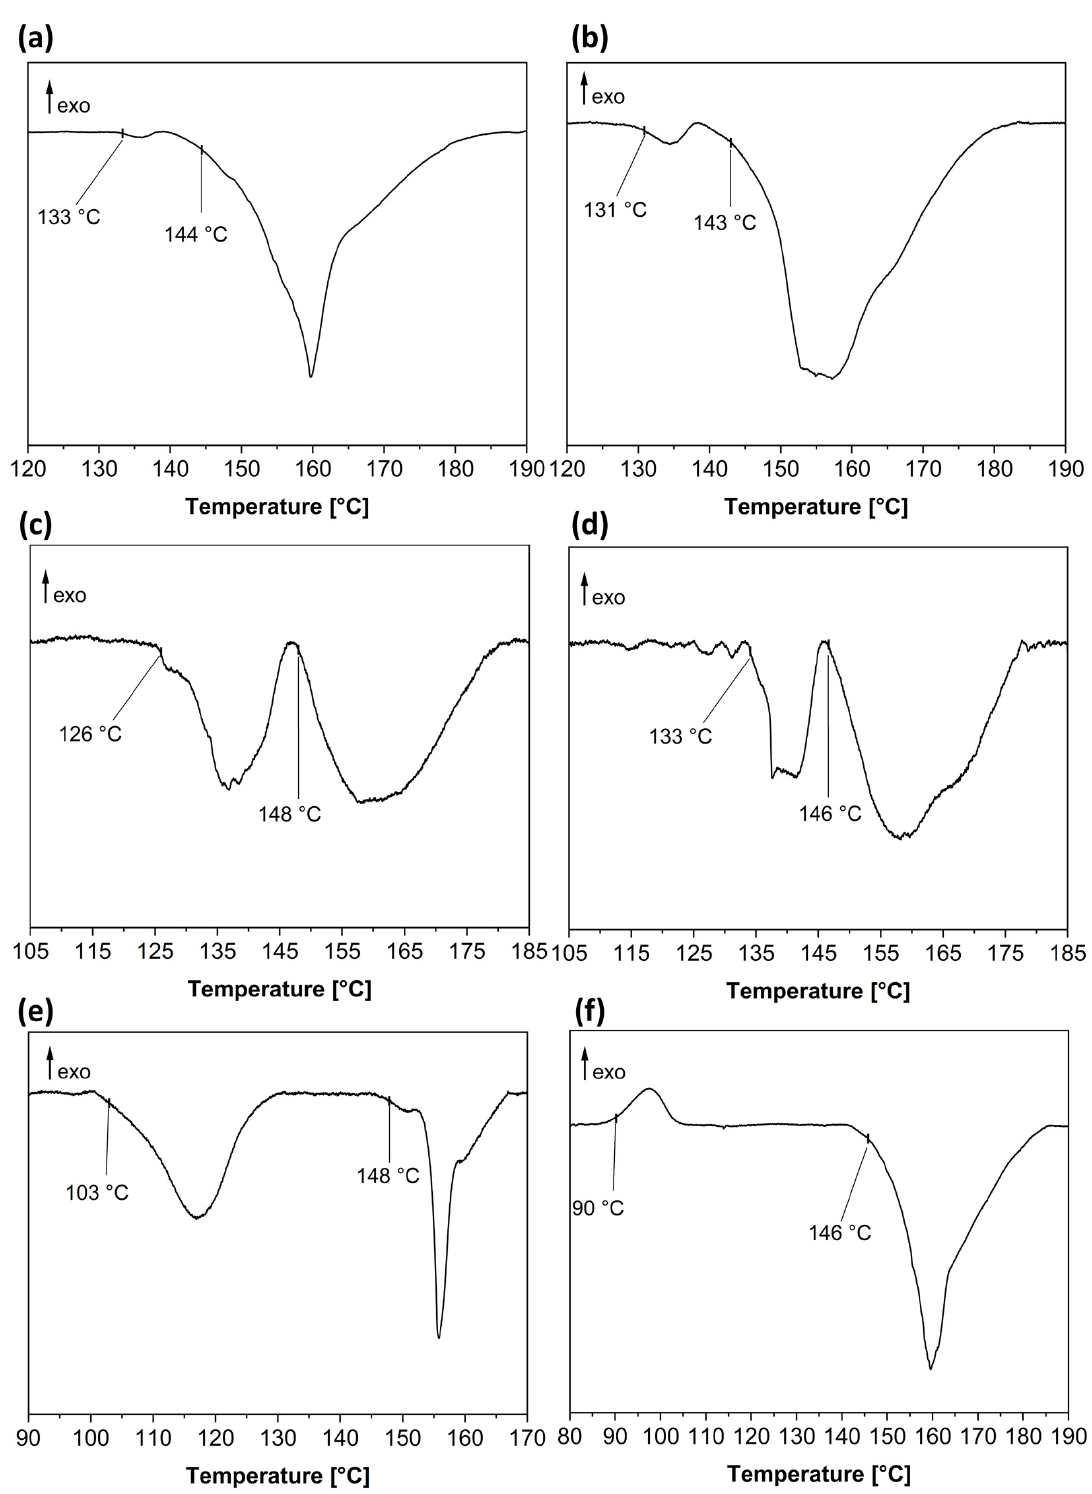
Figure 4. DSC data of the samples grown from aqueous solution. ( a ) Baclofen:D − tartaric acid hydrate, ( b ) Baclofen:L − tartaric acid hydrate, ( e ) Baclofen:DL − tartaric acid hydrate and samples obtained by milling, ( c ) Baclofen:D − tartaric acid, ( d ) Baclofen:L − tartaric acid, and ( f ) Baclofen:DL − tartaric acid. DSC was heated at 5 °C min − 1 ; for clarity, only a temperature range of 70 °C ( a , b , e ), 80 °C ( c , d ), and 110 °C ( f ) is shown.